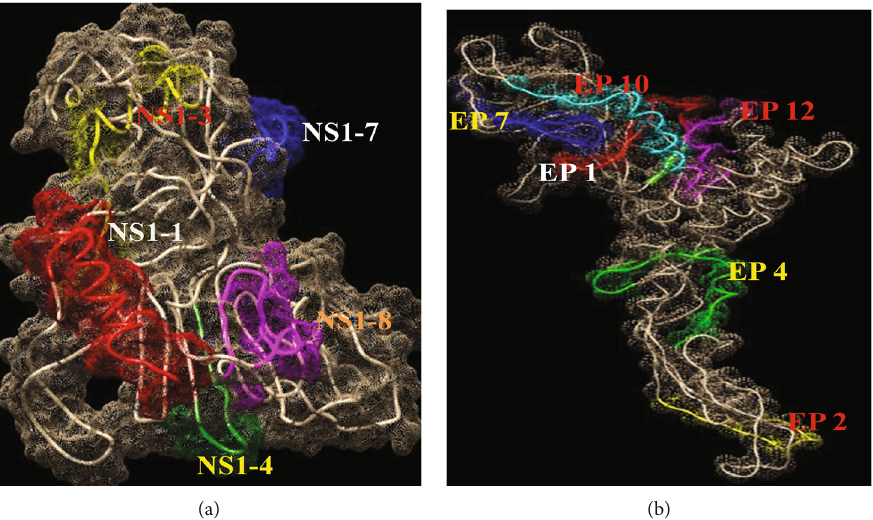
Figure 4: Surface localization of peptides of NS1 (a) and E (b) proteins. All the immunoreactive peptides were present on the surface of proteins. Visualization of peptides was done by using UCSF Chimera 1.12